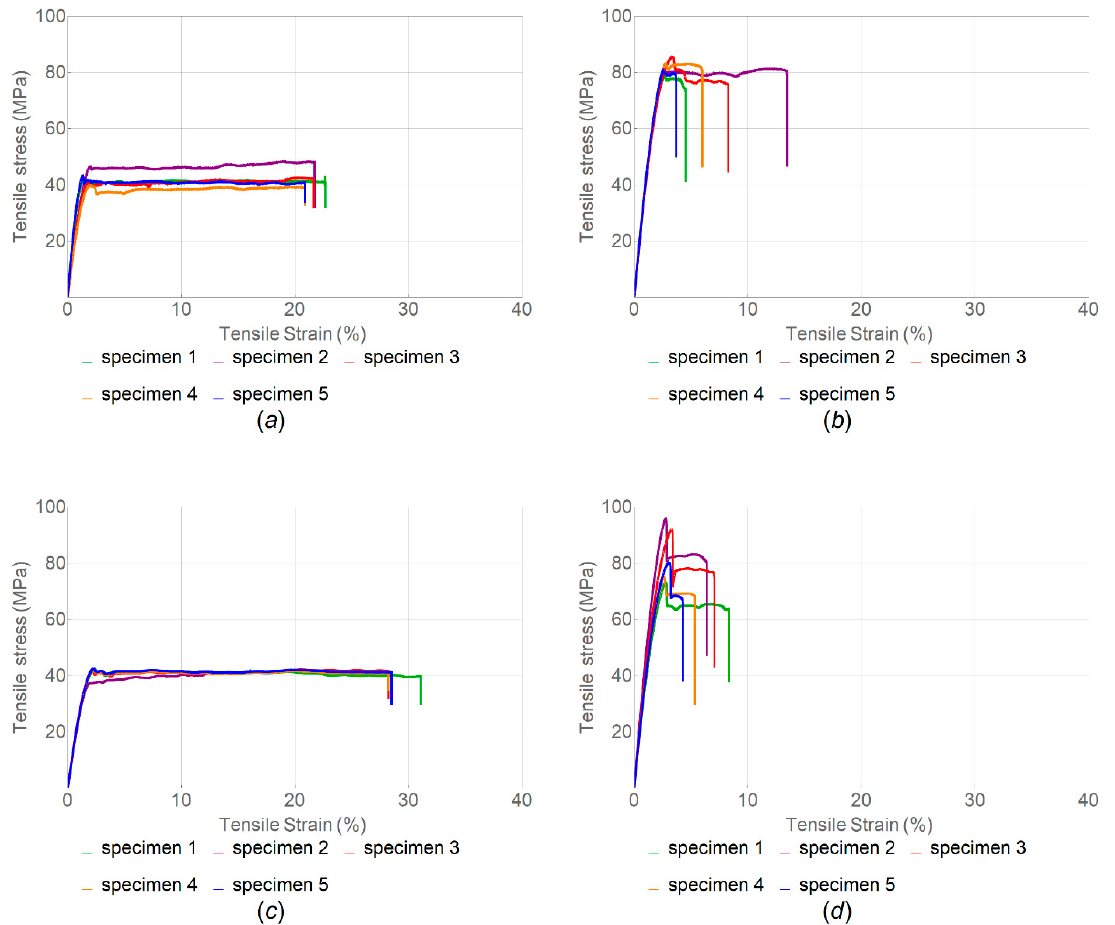
Figure 12. Stress–strain diagrams for extruded filament printed with ( b , d ) and without ( a , c ) heat treatment, (( a , b )—0.4 mm nozzle; ( c , d )—0.6 mm nozzle). treatment, (( a , b )—0.4 mm nozzle; ( c , d )—0.6 mm